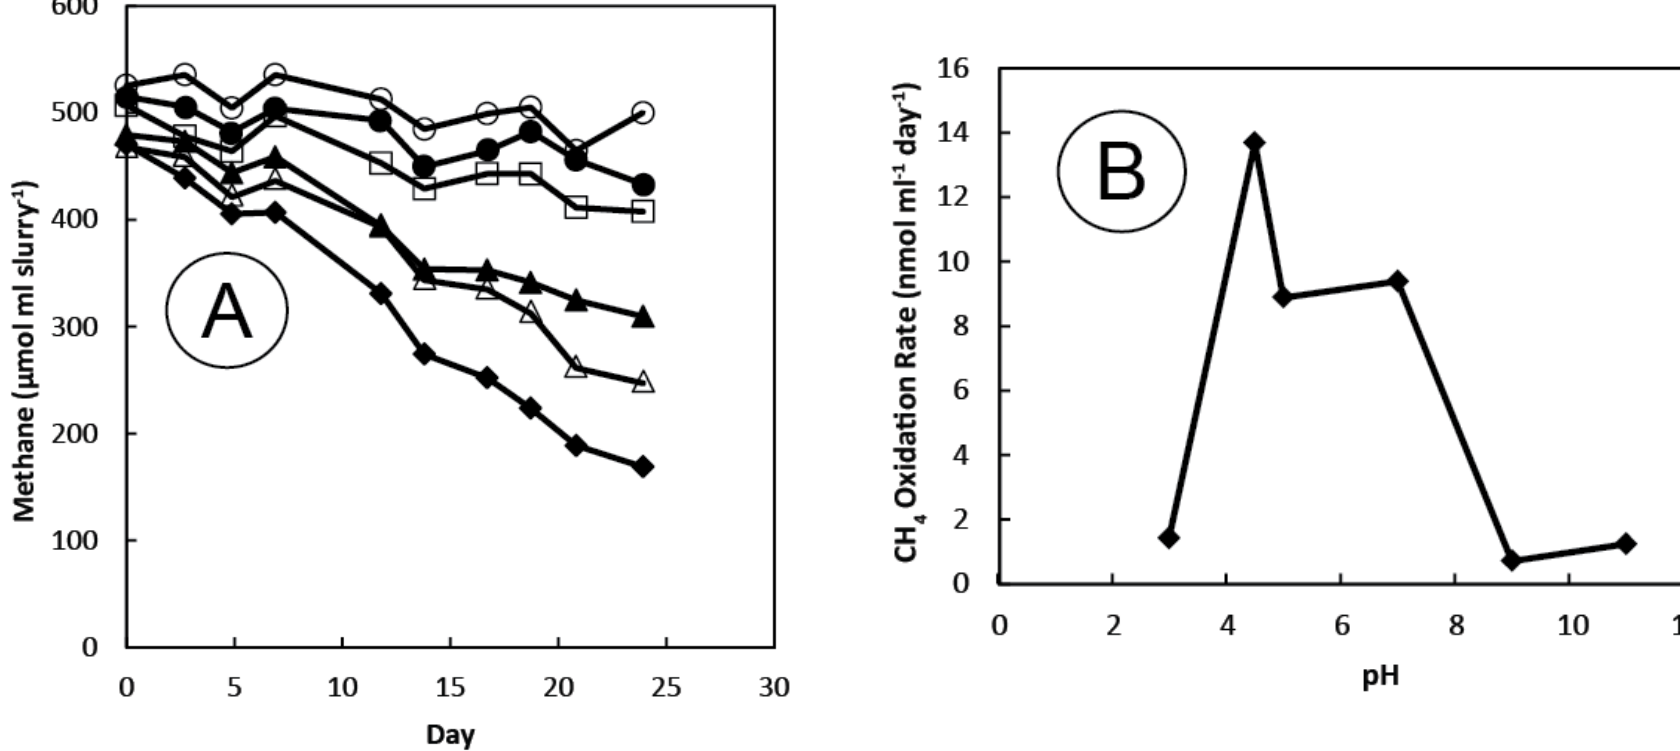
Figure 2. Consumption of methane by sediment slurries incubated at different buffered pH values. ( A ) Symbols for pH: □ (3.0), ♦ (4.5), ▲ (5.0), ∆ (7.0), ● (9.0), ○ (11.0). ( B ) Rates of methane consumption as extrapolated from the slopes of the uptake curves displayed in panel ( A ). Results represent the progress curves for single ( n = 1) experimental sediment slurry incubations held at the given pH values. The r 2 values (std. error) of the negative slopes of the regression lines obtained from panel A as applied to panel B were: pH 3: 0.49 (0.31); pH 4.5: 0.99 (0.59); pH 5.0: 0.90 (1.51); pH 7.0: 0.95 (0.82); pH 9.0: 0.20 (0.31); and pH 11.0: 0.37